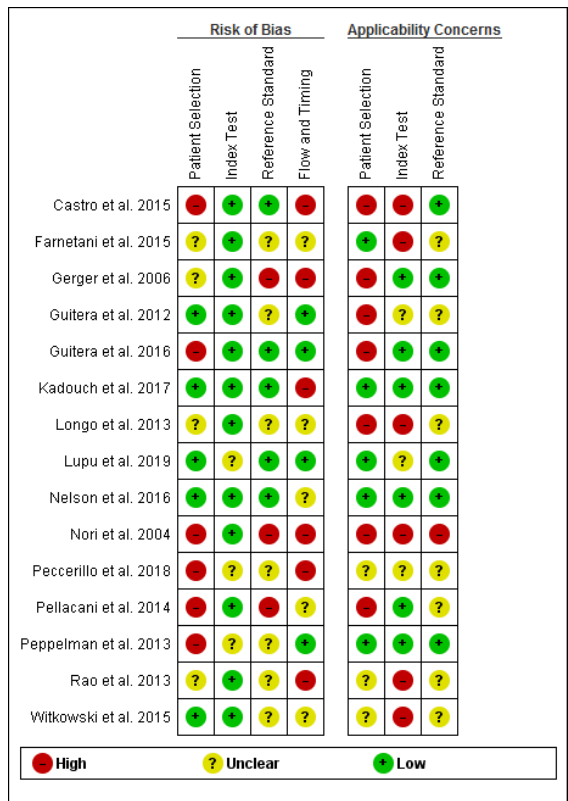
Figure 2. Included studies according to QUADAS-2 guidelines. J. Clin. Med. 2019 , 8 , x FOR PEER REVIEW